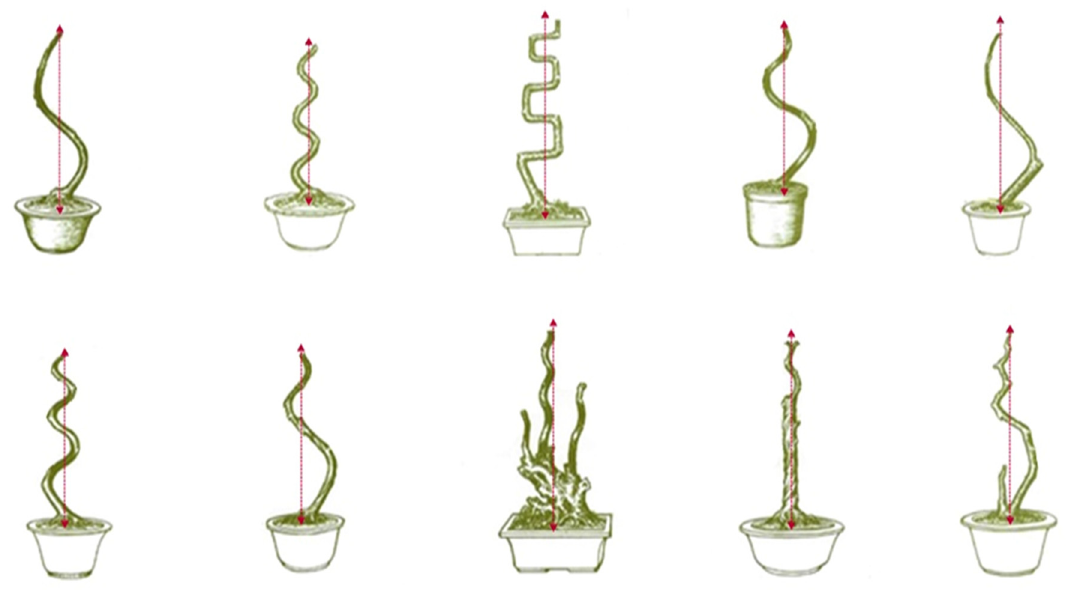
Figure 2. The position of the central axis of regular-style Sichuan potted landscapes. Table 1. Overall modeling analysis of 10 shapes of regular-style Sichuan potted landscapes.